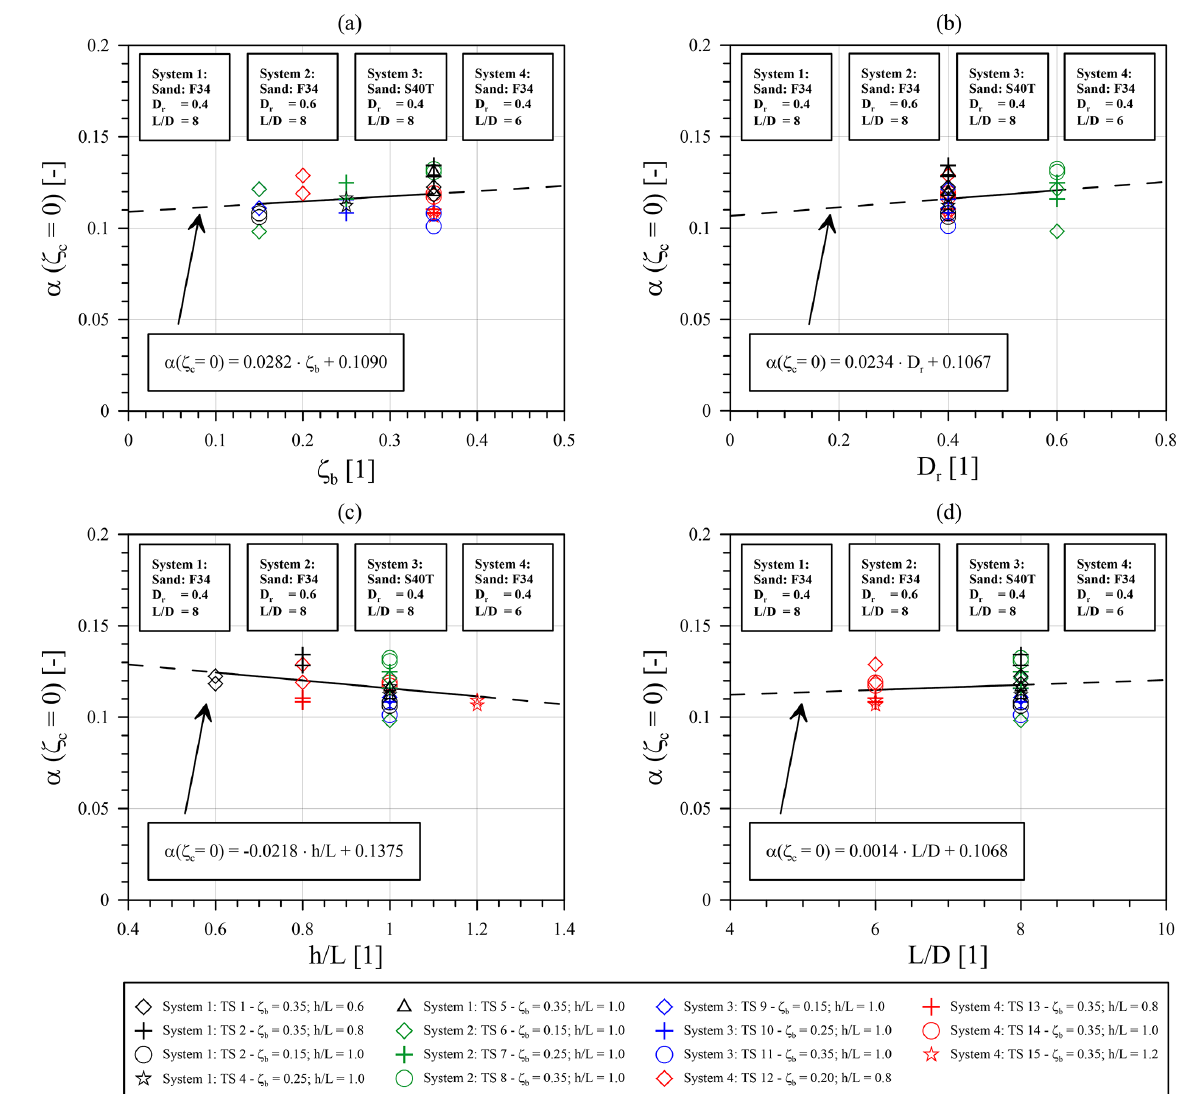
Figure 7. Evaluation of cyclic test results: relationship of the accumulation parameter α for ζ c = 0 with (a) load magnitude ζ b , (b) soil relative density D r , (c) normalized load eccentricity h/L and (d) normalized embedment length L/D